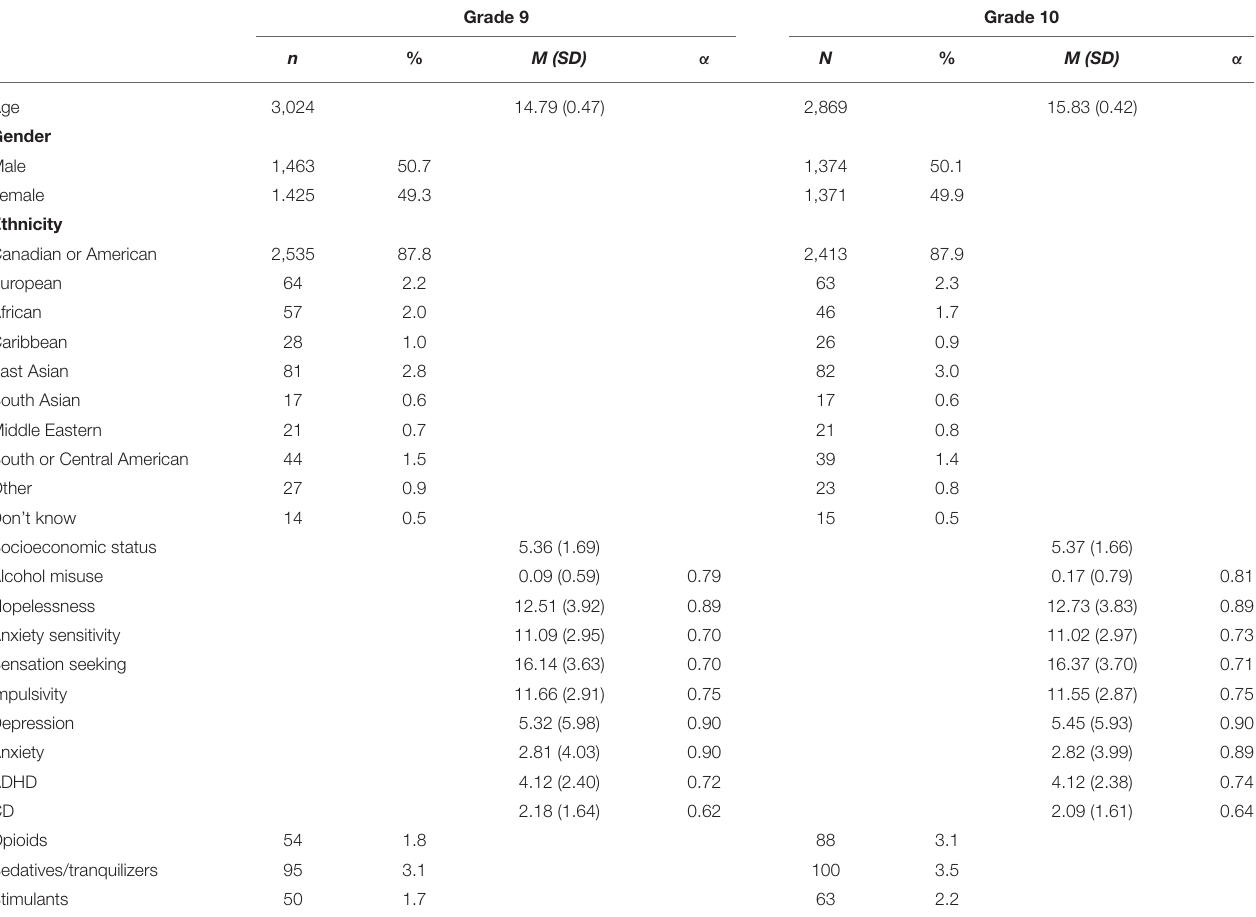
TABLE 2 | Frequencies and descriptive